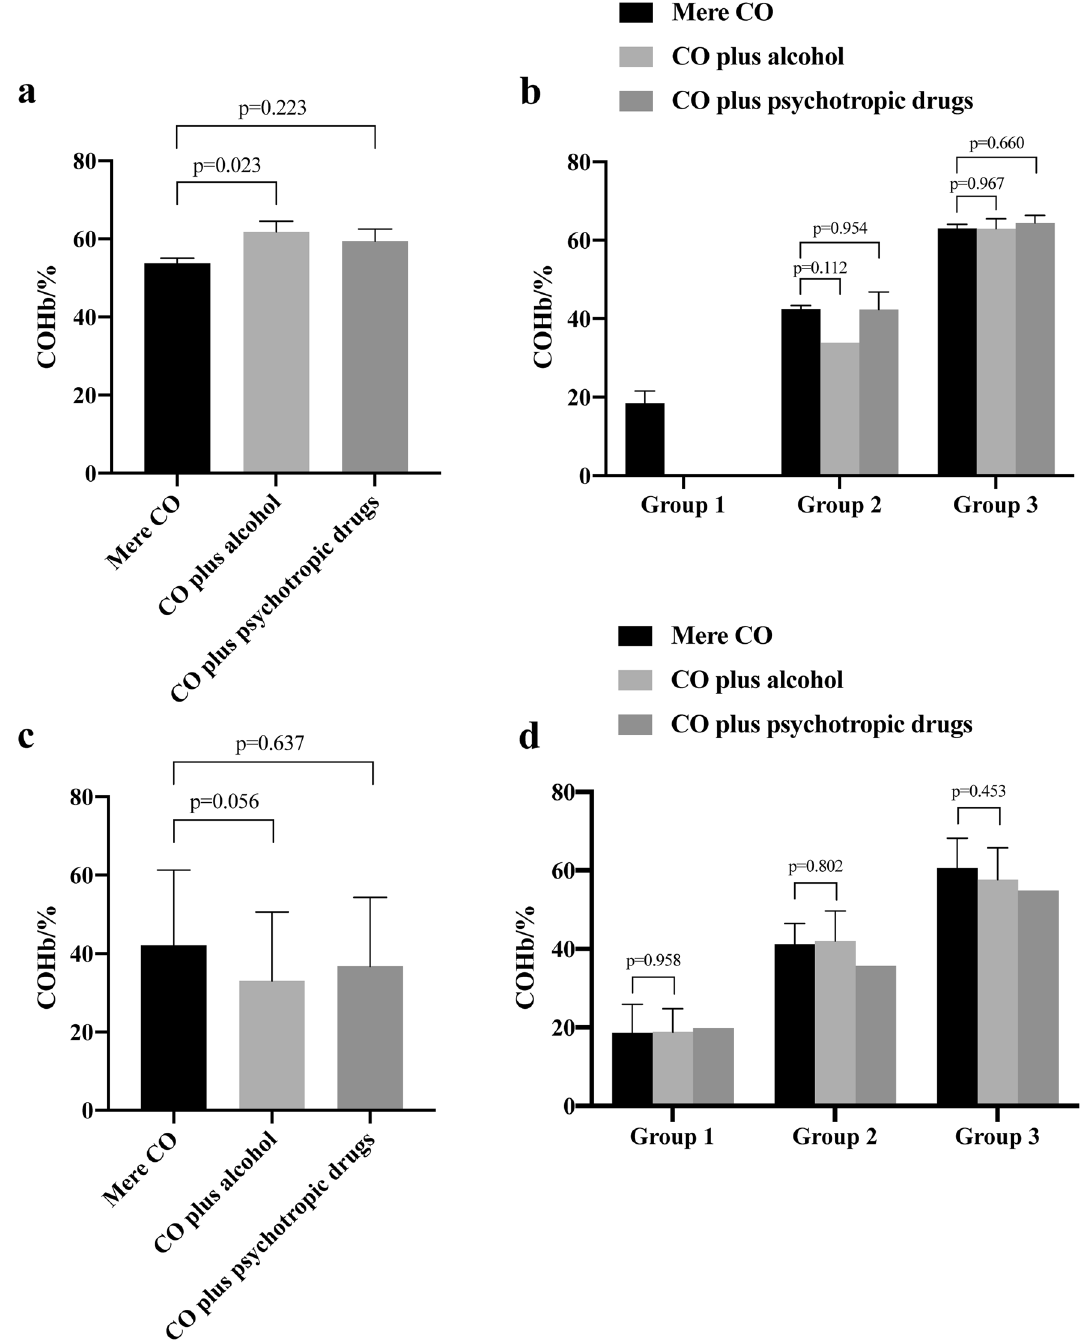
Figure 3. Distribution of COHb saturation by toxicological results in decedents died from CO poisoning. ( a , b ) In the fire-unrelated CO poisoning cases (n = 174), the distribution of COHb saturation by toxicology in all the cases ( a ) or in each subgroup ( b ) was presented. ( c , d ) In the fire-related CO poisoning cases, the distribution of COHb saturation by toxicology in the pooled cases ( c ) or in each subgroup ( d ) was presented. p value was as